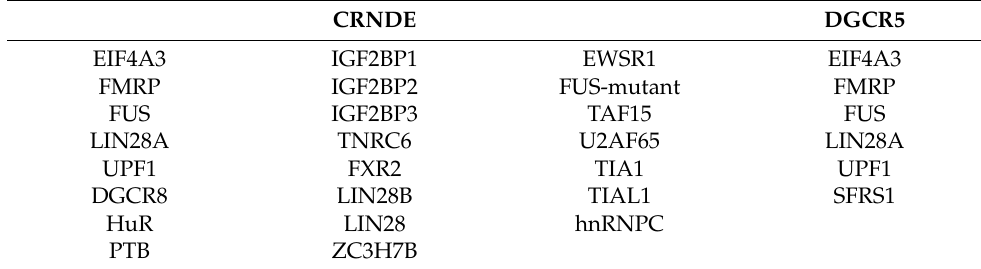
Table 2. RNA-protein binding